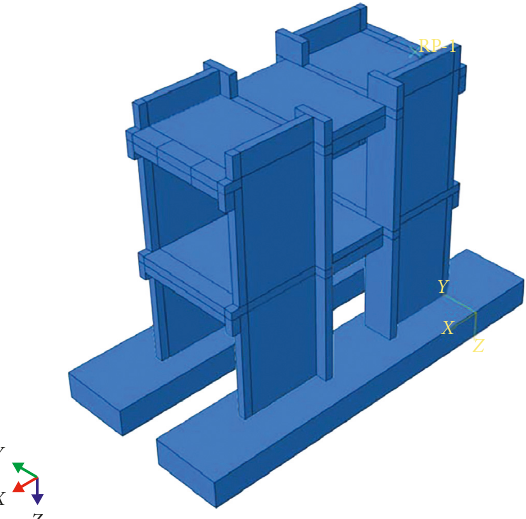
Figure 13: The NPGCS finite-element spatial model.